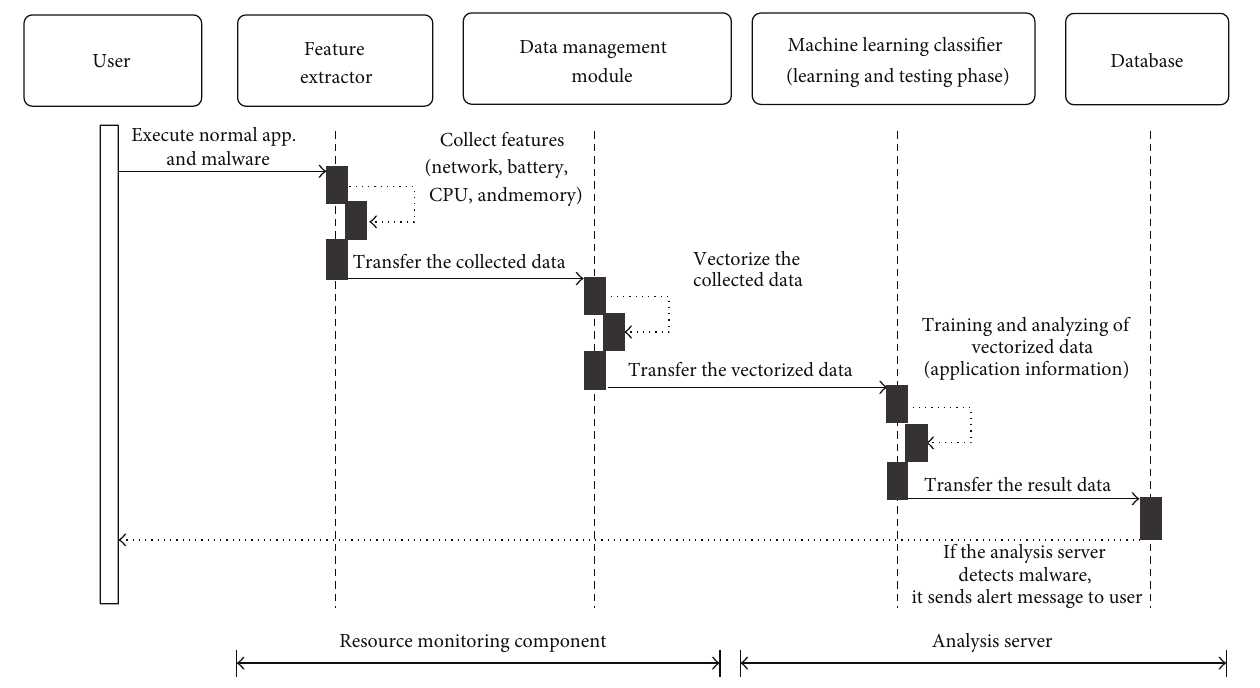
Figure 4: Sequence diagram for malware detection system. Table 3: Features of malware to be